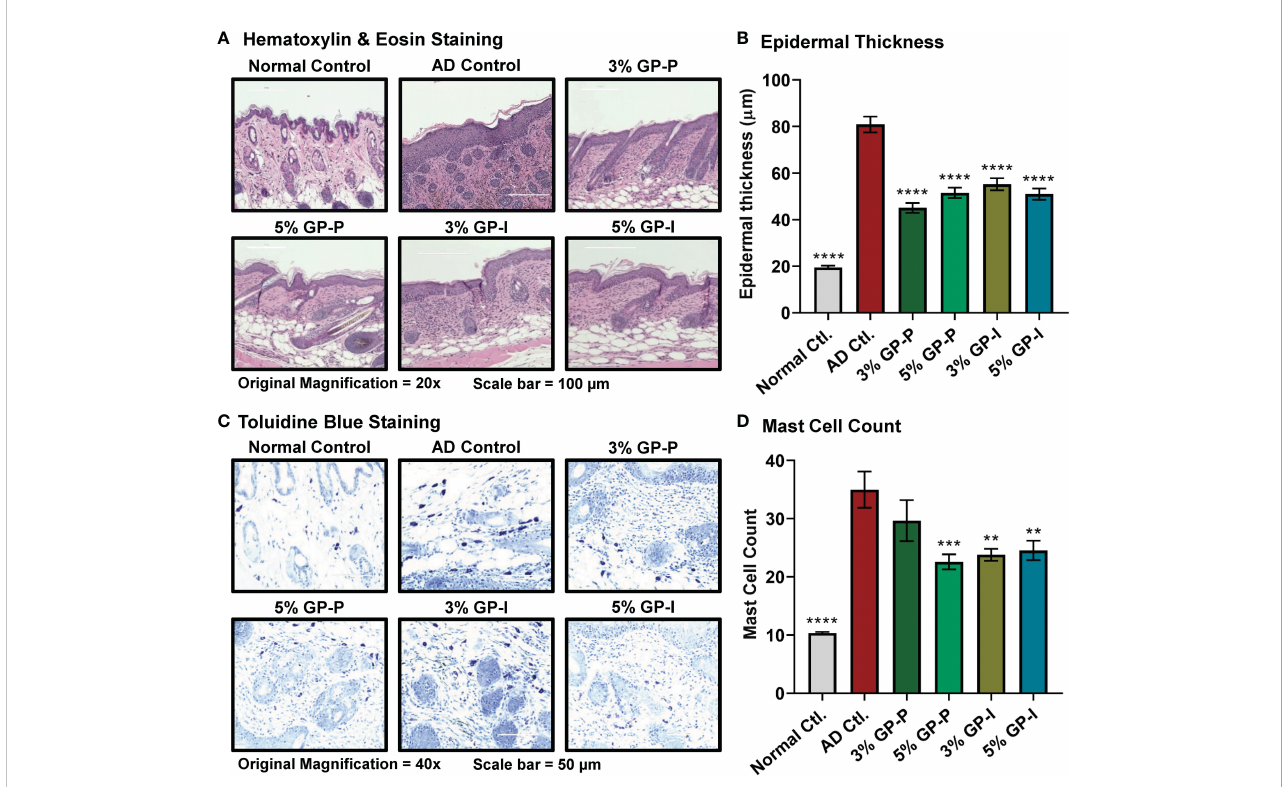
FIGURE 2 Effect of grape powder supplementation against atopic dermatitis-associated changes within skin of NC/NgaTndCrlj mice. (A) Tissue sections were stained with H&E and epidermal thickness was analyzed by measuring the distance from stratum basale to stratum corneum using EVOS FL Cell Imaging System. Representative images are shown. (B) ImageJ software (NIH) was used to average 25 measurements across 5 images at 20x magni fi cation, then averaged per mouse. (C) Tissue sections were stained with toluidine blue for mast cell (violet metachromatic cytoplasmic granules) in fi ltration analysis. At least fi ve images were taken at 40x magni fi cation across fi ve different skin sections of each mouse. Representative images are shown. (D) Mast cells were counted using ImageJ, then averaged per mouse. The quantitative data represents mean ± SEM of fi ve animals per group. All the analyses were compared with AD control. A one-way ANOVA with Dunnett ’ s multiple comparisons test was performed (**p<0.01, ***p<0.001,